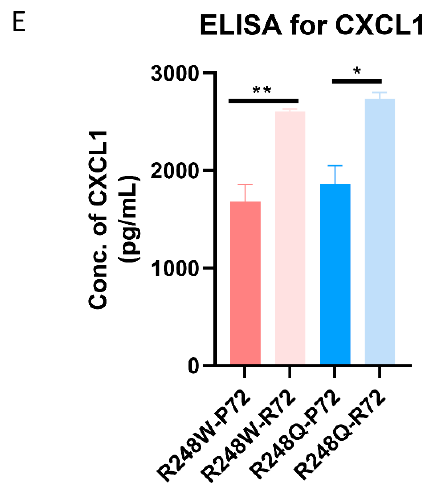
Figure 2. CXCL1 is significantly overexpressed in p53 mutants with the R72 SNP ( A ) Heat map showing gene expression profiles of mutants R248W and R248Q with the P72 or R72 SNP. Transcripts for CXCL1, CDH1, CDH2 and TP53 are shown. Experiment consists of three independent biological and technical replicates. ( B ) Principal Component Analysis (PCA) indicating percent variance between the respective mutant pairs. ( C ) MA plots showing CXCL1 significantly overexpressed relative to CDH1, CDH2 and TP53 across both p53 mutant pairs (R72 group n = 6, P72 group n = 6). ( D ) mRNA expression profiles of each pair of mutant shows significant overexpression of R248Q P72 compared to R248Q R72 and R248W P72 compared to R248W R72 using RT-qPCR. ( E ) Sandwich ELISA assay used to determine concentration of CXCL1 in the cellular media supernatant for each mutant pair. All data shown as mean ± SEM. The statistical analysis was performed using two-tailed Student’s t-test: * p ≤ 0.05, ** p ≤ 0.01,